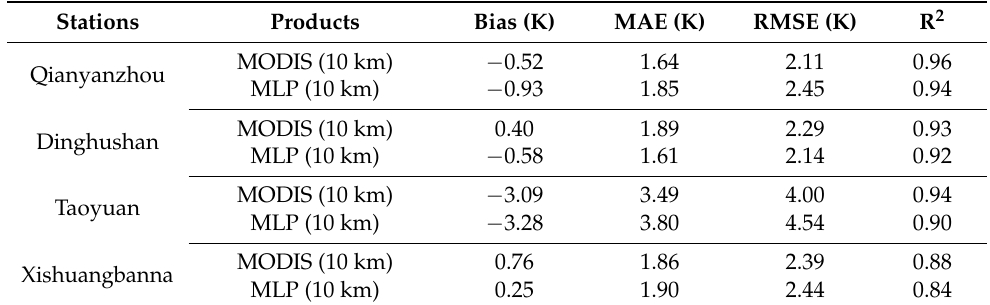
Table 4. Comparisons of the aggregated 10-km MODIS LST and MLP LST against the ERA5-Land LST. Stations Products Bias